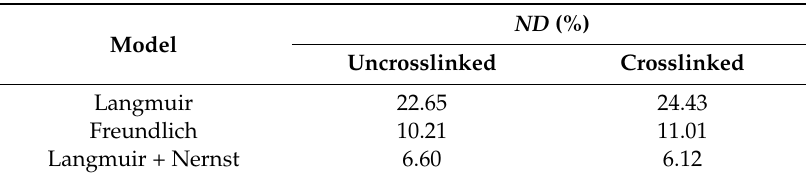
Table 1. Normalized deviation of three isotherm